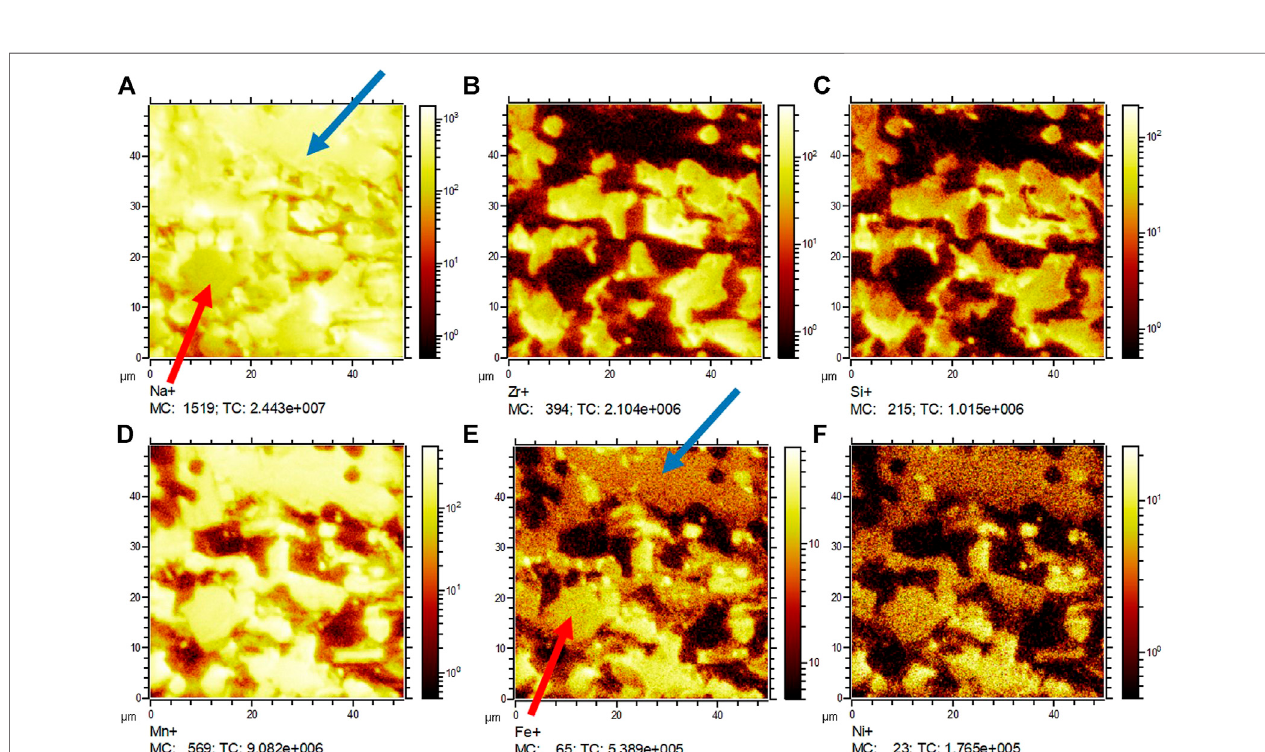
FIGURE 8 | SIMS analysis results of co-sintered NNFM/NZSiP specimen. Arrows highlighting Na rich (blue) and Na poor (red) NNFM regions.